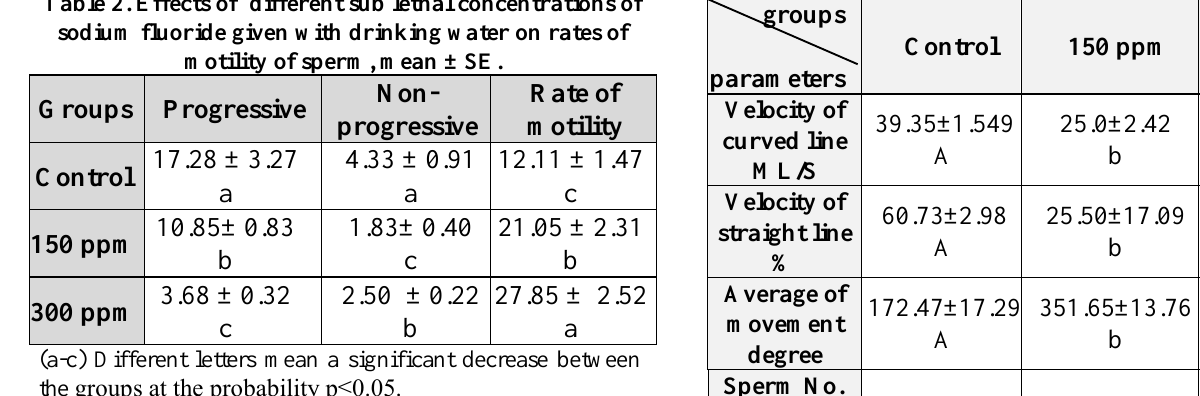
Table 4. Effects of different sub lethal concentrations of sodium fluoride given with drinking water on the various velocity of sperm and rectilinear movement, mean ±